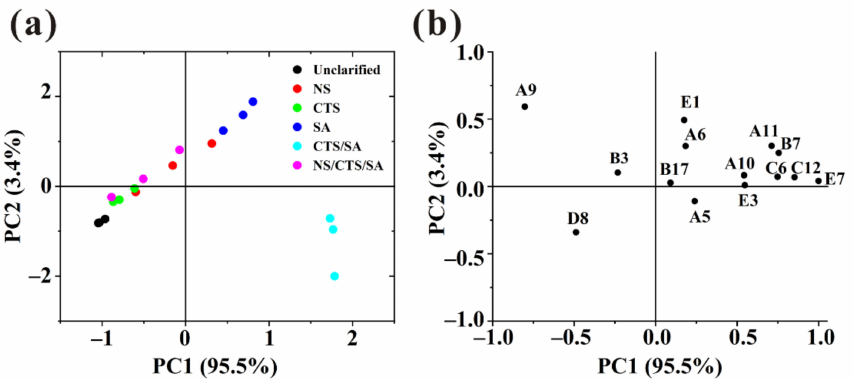
Figure 4. Principal component analysis (PCA) plots of the key odor compounds identified by different clarification methods. ( a ) PC1 vs. PC2 score scatter plot; ( b ) loading weight plot (codes correspond to the compounds described in Table